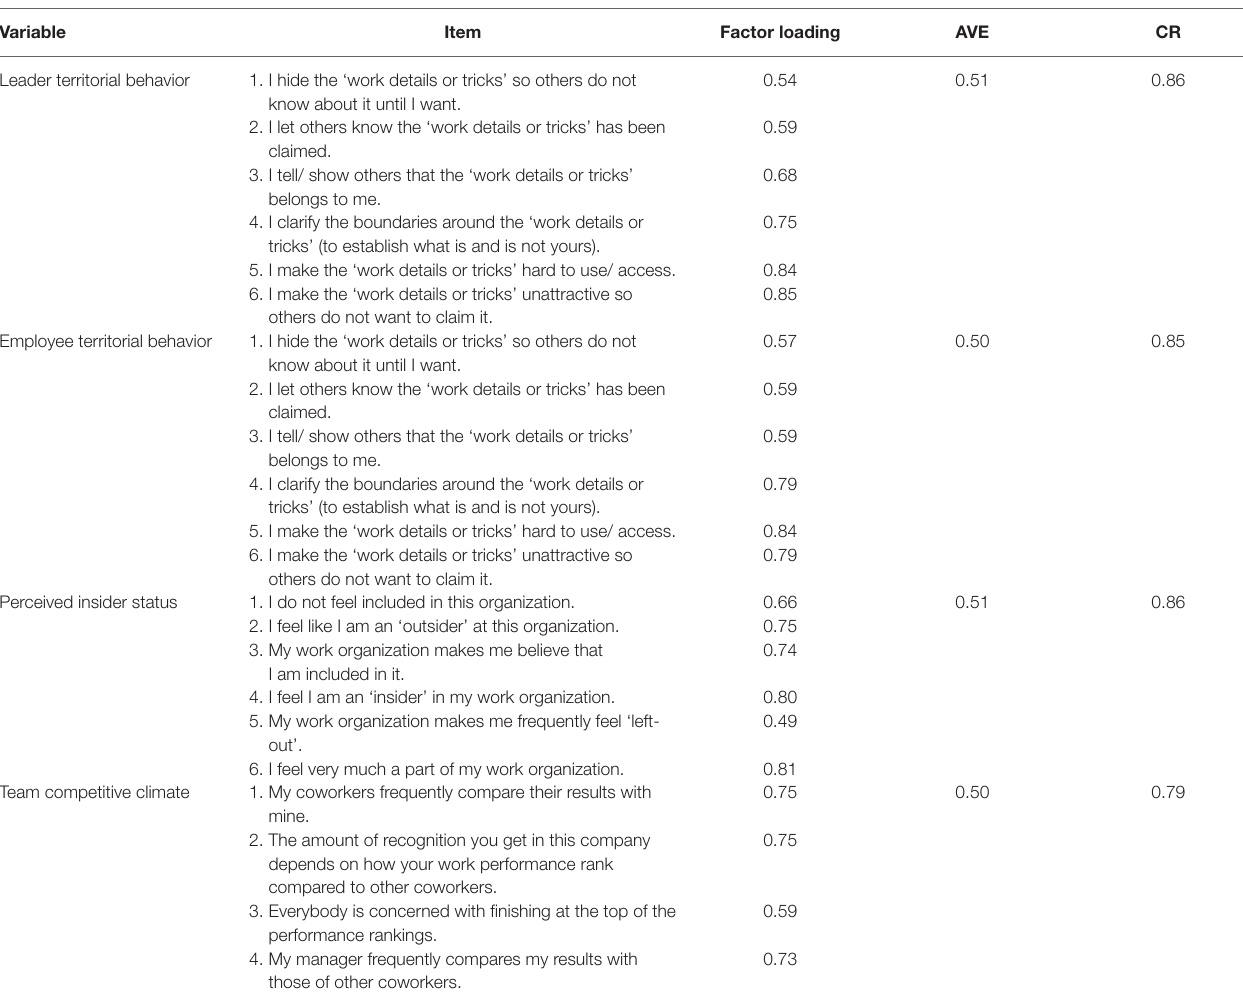
TABLE 3 | Convergent validity.